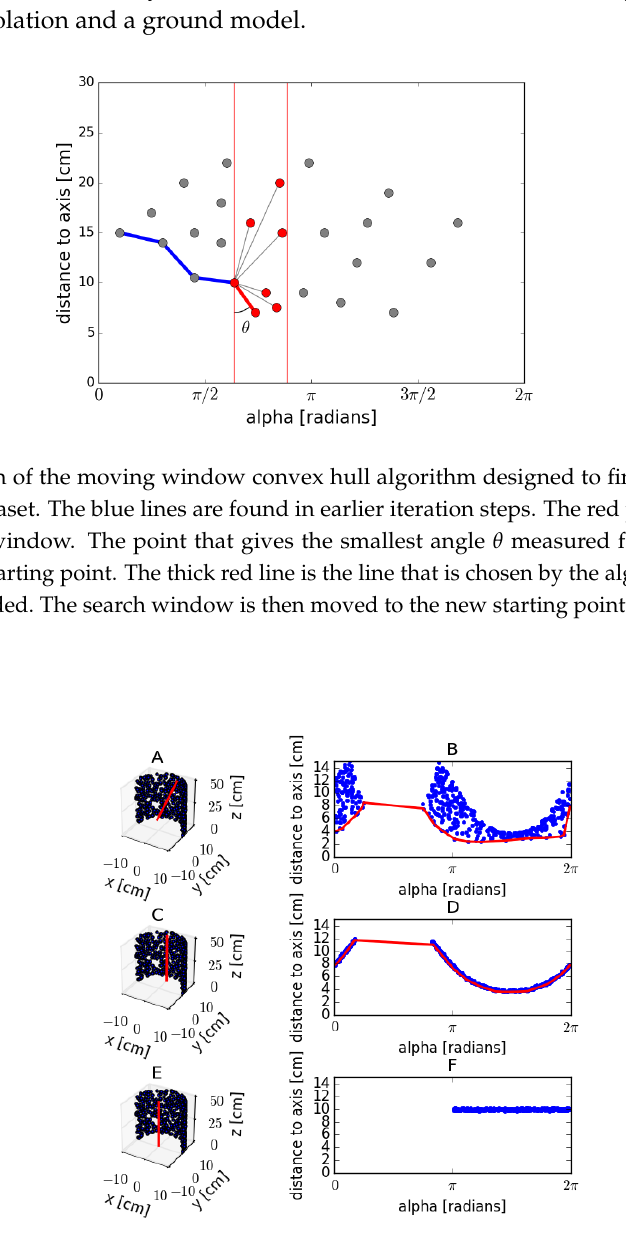
Figure 7. Cylinder fitting of a synthetic point dataset with radius 0.10 m. ( A , C , E ) The perspective views of semi-cylinder point data with different axis positions. The axis positions are marked in red. ( A ) The axis is positioned at the centroid of the point dataset and tilted 10 ◦ ; ( C ) the axis is positioned at the centroid of the point dataset and is aligned with the true cylinder axis; ( E ) the axis is positioned at the true center of the cylinder and is aligned with the true cylinder axis. ( B , D , F ) The radial displacement as a function of the angle of the axis positions in ( A , C , E ); the red lines in ( B , D ) are calculated by a moving window convex hull algorithm and are used as a base level from which to calculate the deviation of the